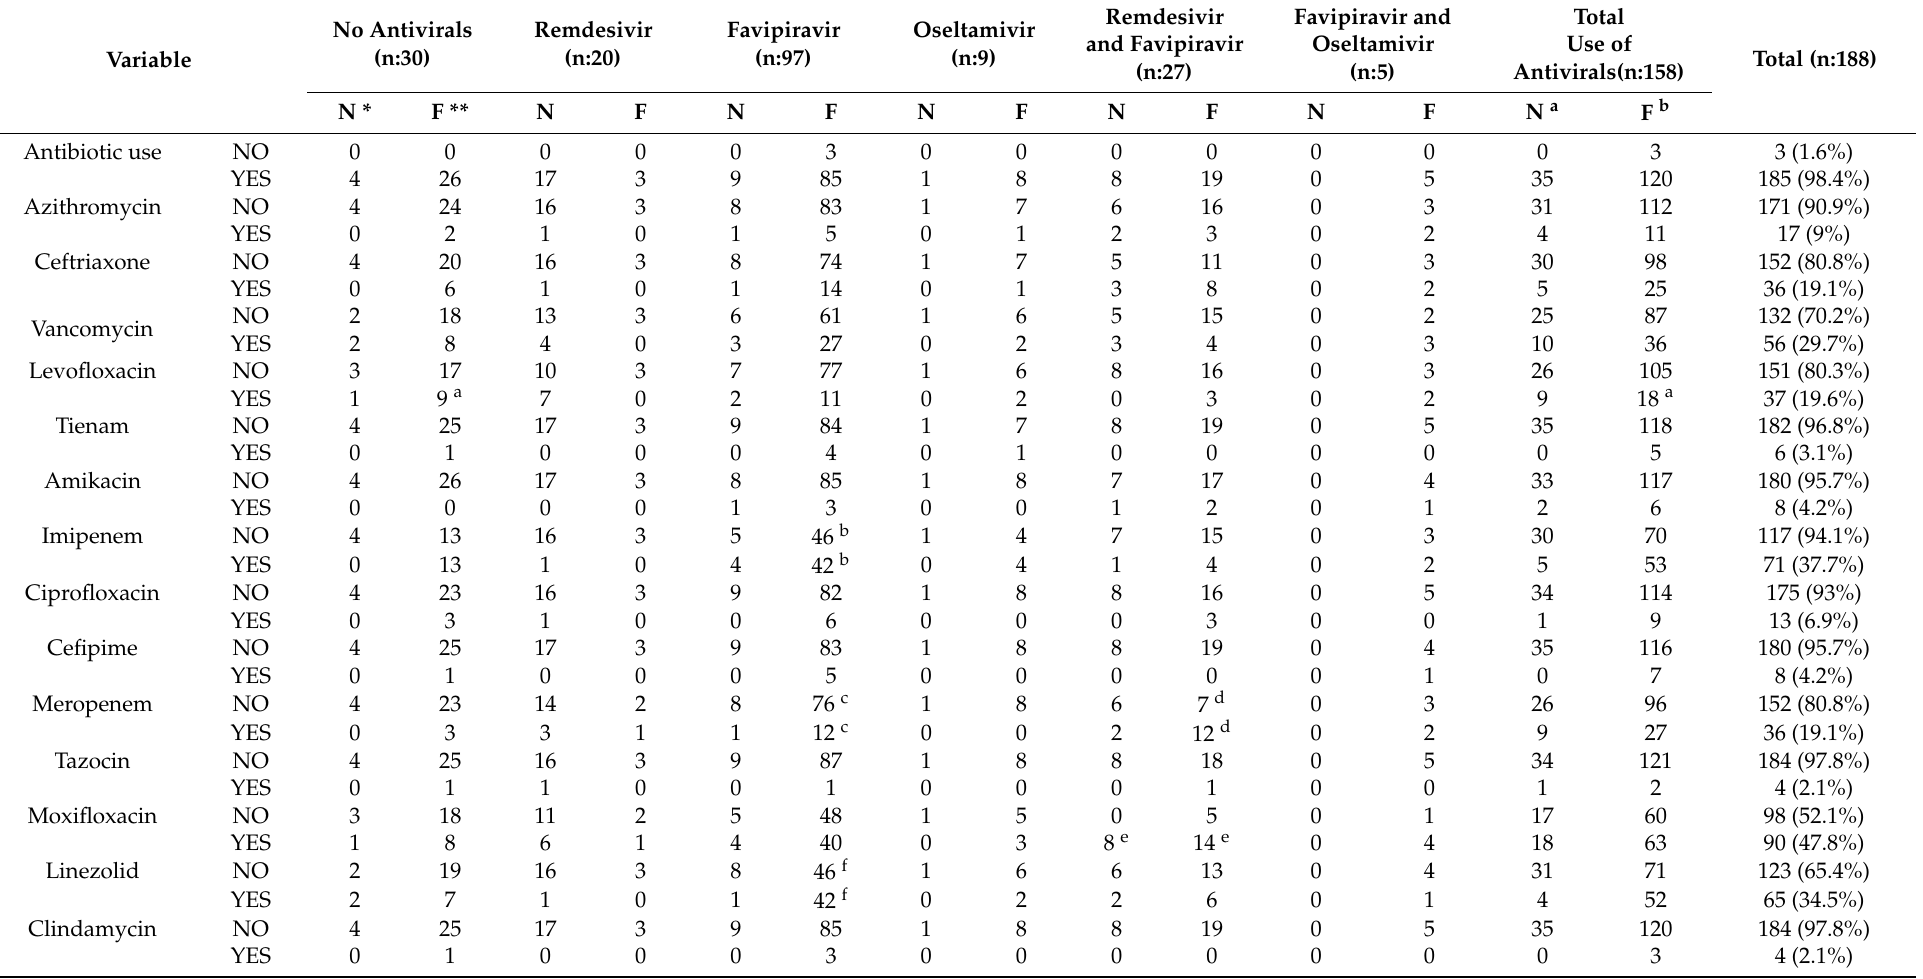
Table 3. Antibiotics used in critical COVID-19 patients with different antiviral